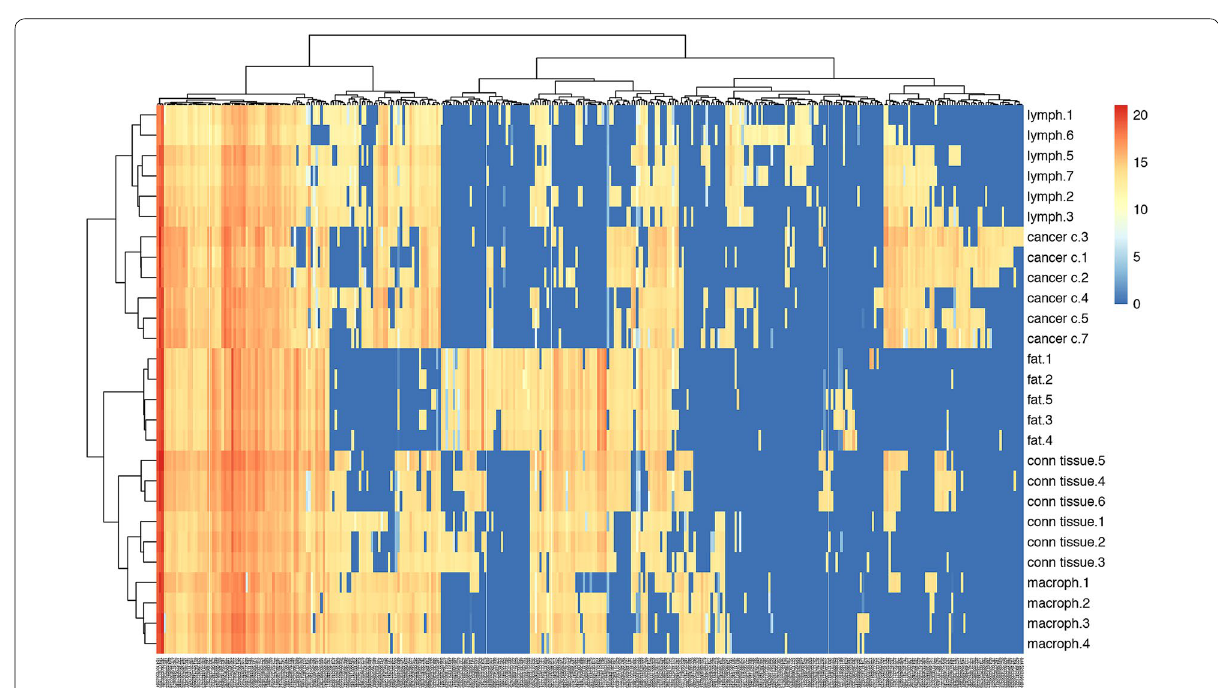
Fig. 5 Heat map generated from the metabolite peak lists of the respective cell types in melanoma tissue samples isolated after surgery